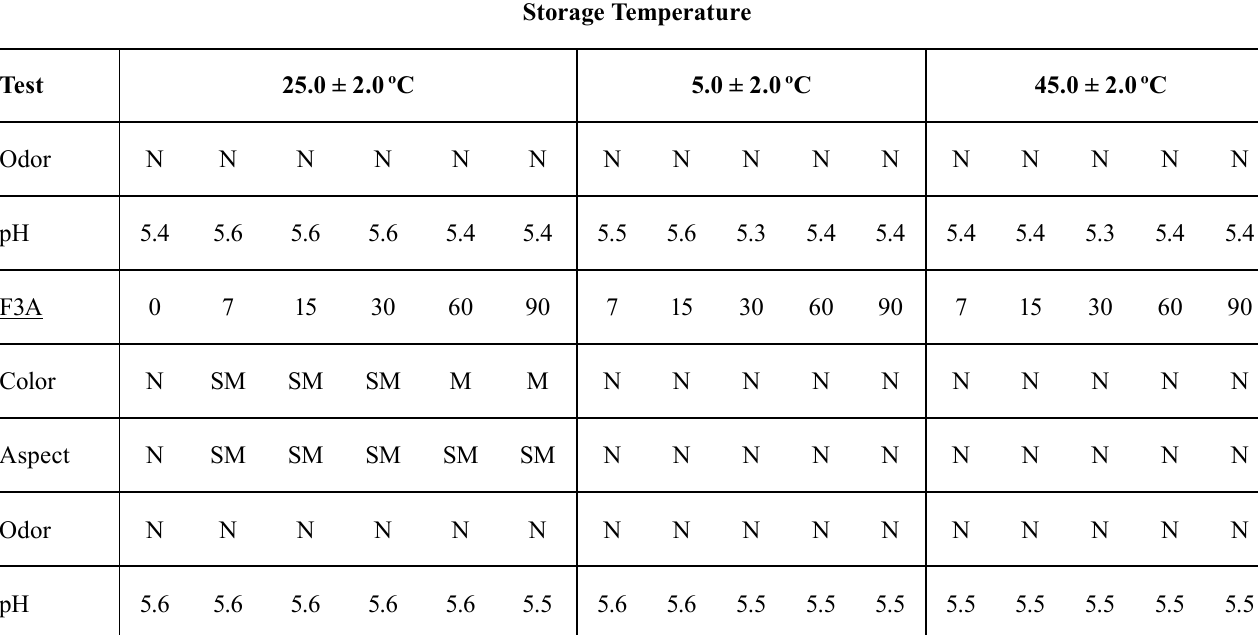
TABLE III – Organoleptic characteristics (aspect, color and odor) and pH value submitted to the Normal Stability Assessment ( NSA ) during the 90